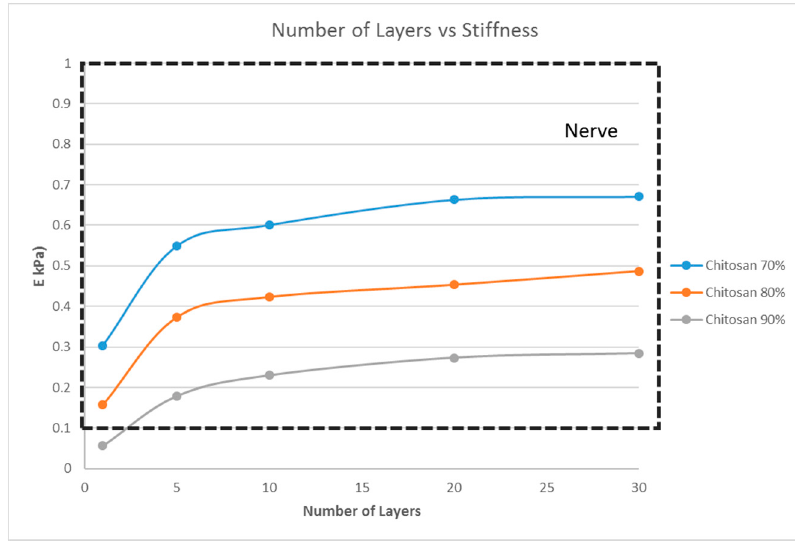
Figure 7. Effect of the number of layers on the stiffness of the structure with a fixed unit cell pore side length ( p = 200 μ m) at three different porosity values (70%, 80%, 90%) for chitosan.